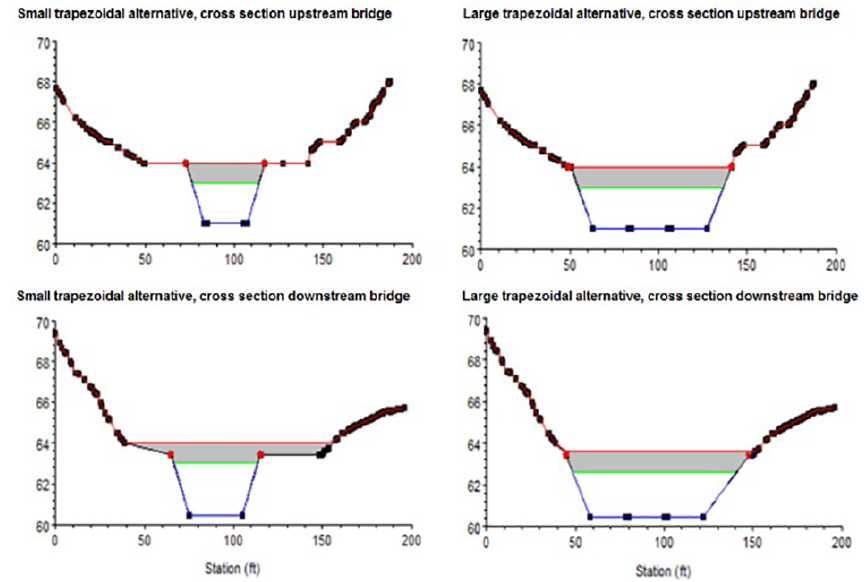
Figure 8. Geometric alternatives of stream modification considered in the HEC-RAS simulation.